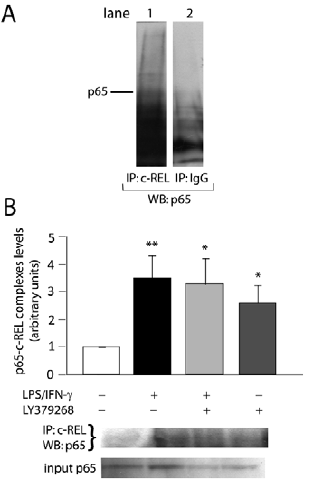
Figure 3. Both LPS/IFN- c and LY379268 induce p65-c-Rel dimerization. Astrocytes were incubated with LPS/IFN- c (1 m g/mL/ 50 ng/mL) 6 100 m M LY379268 for 30 min. Interaction between p65 and c-Rel proteins was analyzed from 70 m g of proteic nuclear extracts by co-immunoprecipitation (IP) with anti-c-Rel antibody followed by western-blot (WB) for p65. (A) Specificity of the assay was analyzed by immunoprecipitating nuclear proteins with anti-c-Rel antibody (lane 1) or with an irrelevant IgG of the same origin as the anti-c-Rel antibody (lane 2), which was not able to precipitate c-Rel-linked p65. (B) Levels of anti-c-Rel-immunoprecipitated p65 were expressed relative to control group. Bars represent the mean 6 SEM of 3 independent experiments. *p , 0.05, **p , 0.01 versus control. Input corresponds to total content of p65 in nuclear extracts.